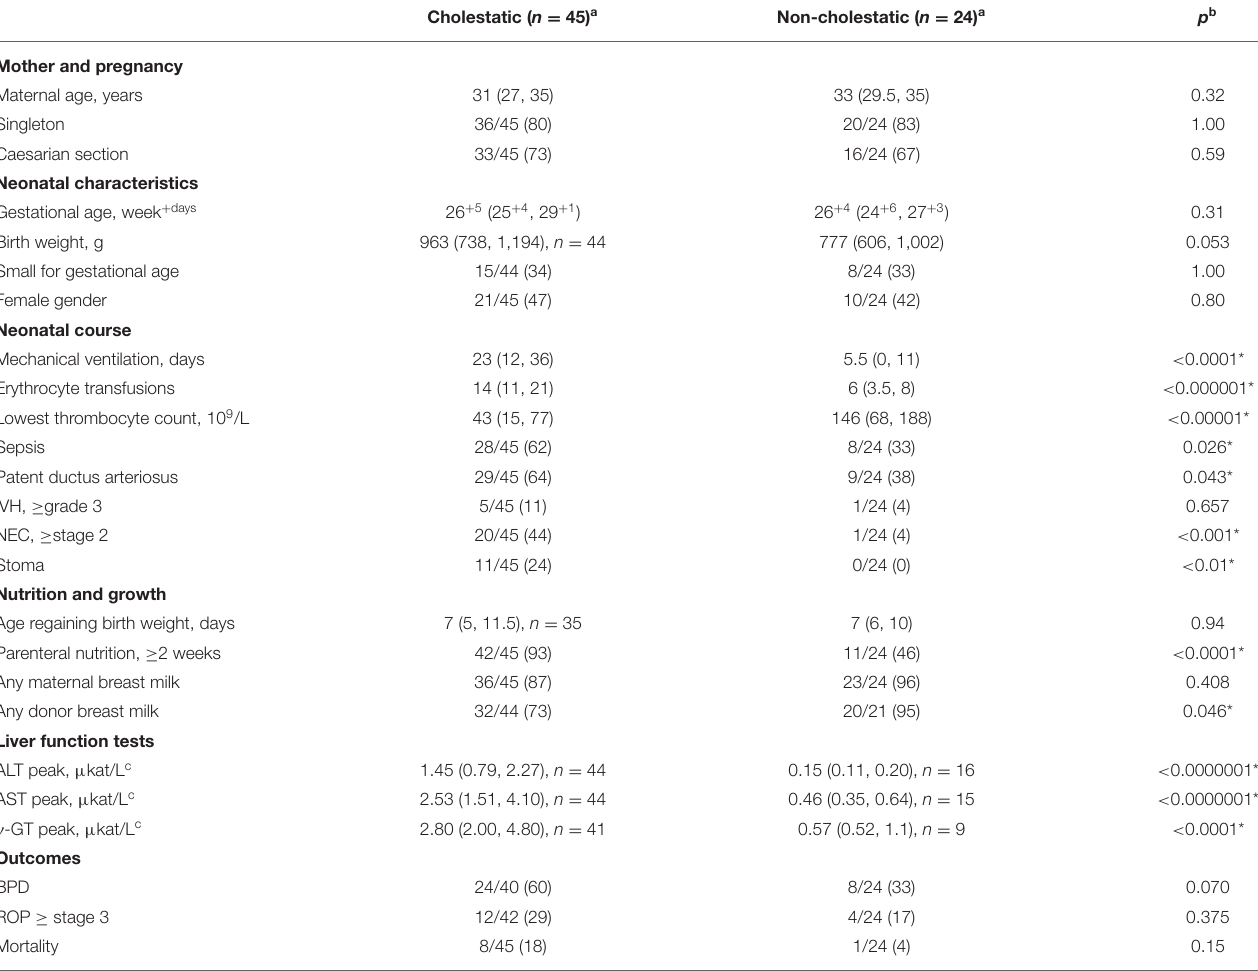
TABLE 1 | Characteristics of cholestatic and non-cholestatic preterm infants. Cholestatic ( n = 45) a Non-cholestatic ( n = 24) a p